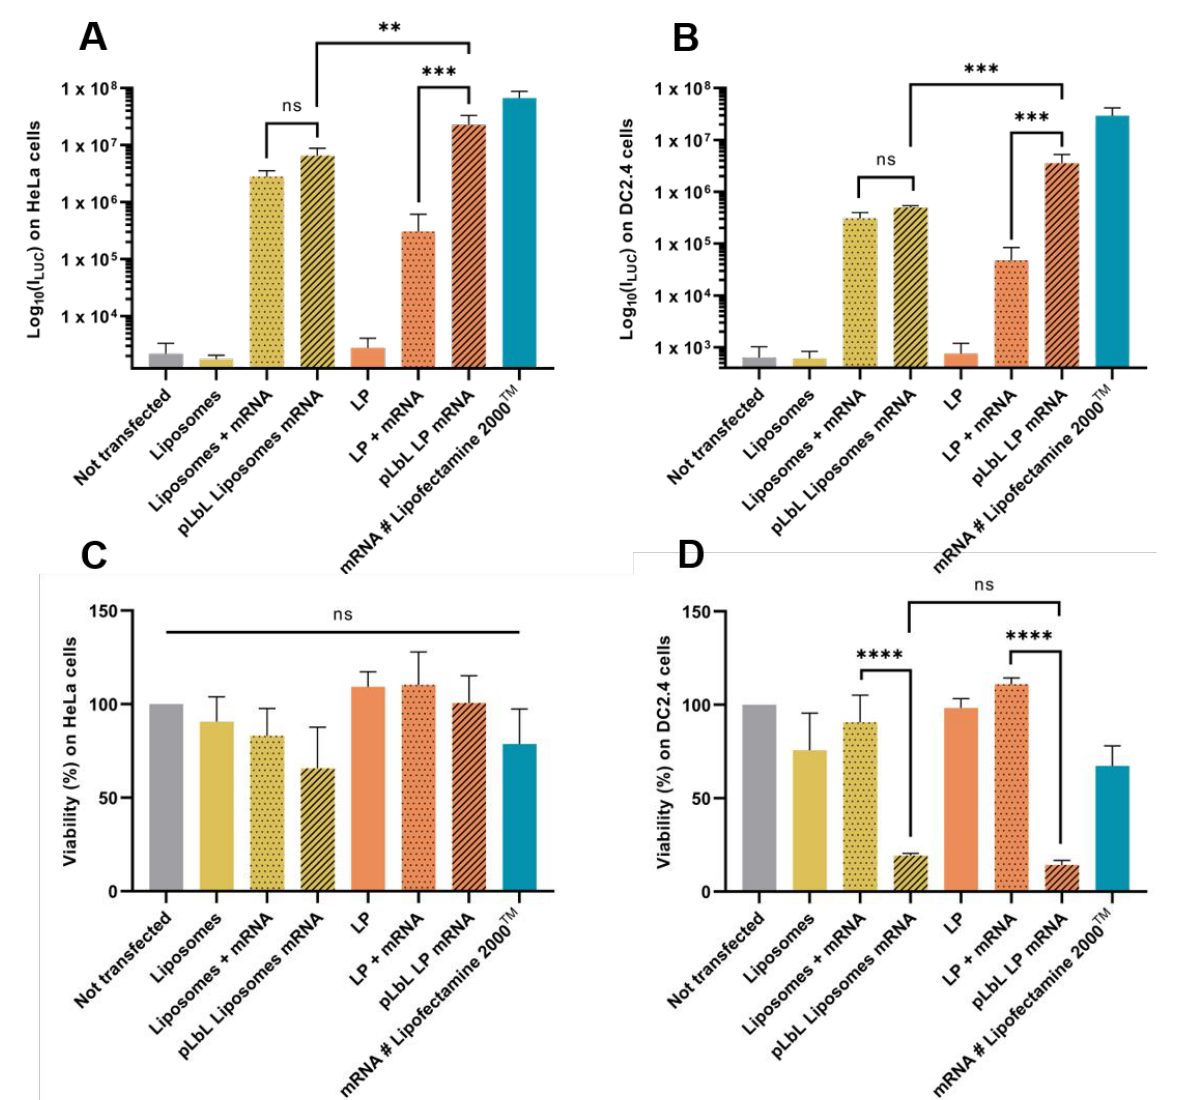
Figure 4. In vitro evaluation at +24 h (top) of transfection efficiency through measurement of luminescence intensity (Bright-Glo luciferase assay) and (bottom) cell viability (PrestoBlue assay) obtained after transfection of 90 ng eq. of Fluc mRNA, formulated either in liposomes or in LP using pLbL strategy (ratio mRNA/LAH4-L1 = 1:20 w / w ) on HeLa ( A , C ) and DC 2.4 ( B , D ) cells. Lipofectamine 2000 TM was used as positive control. Data are presented as mean ± SD and statistically analyzed using one-way ANOVA followed by Tukey’s multiple comparison test (not significant (ns): p > 0.01, **: p < 0.001, ***: p < 0.0001 and ****: p < 0.00001).